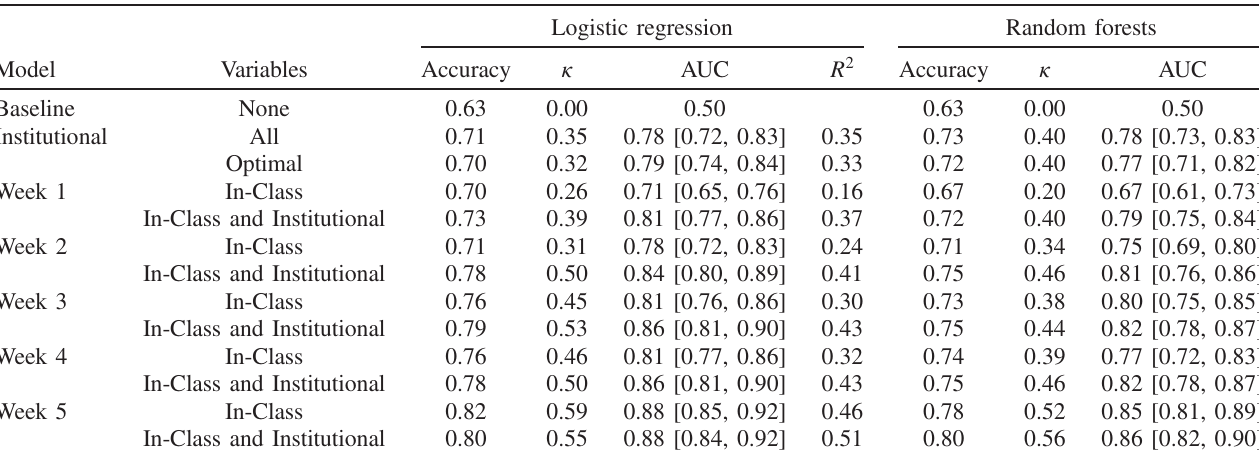
TABLE III. Physics 1: Logistic and random forest model performance. The 95% confidence interval for AUC is shown in brackets.